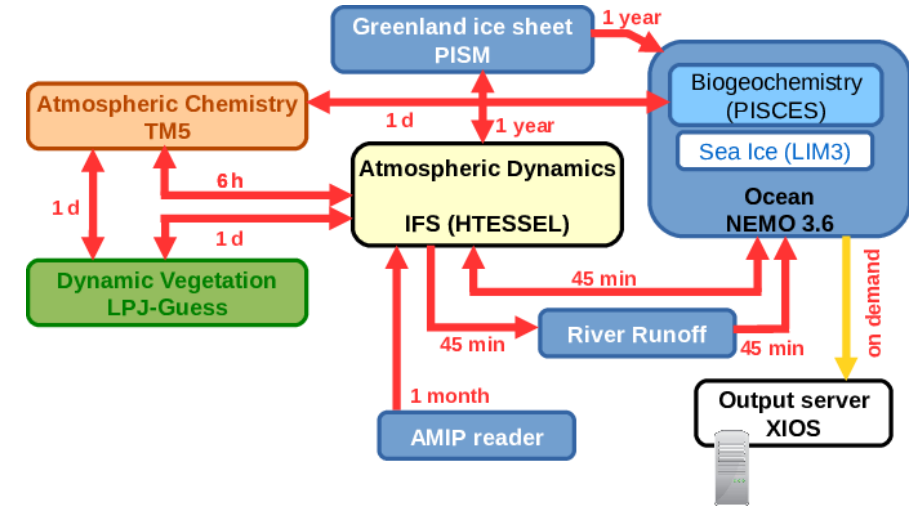
Figure 1. Coupling links and typical frequencies at standard resolution between all components that potentially can be coupled. Existing configurations include subsets of component models and associated couplings. Table 3. Variables and fluxes exchanged at the ocean–atmosphere interfaces.